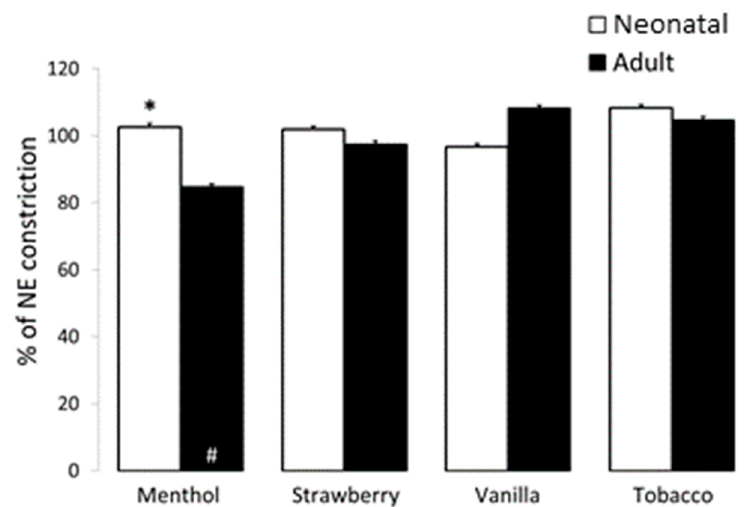
Figure 4. E ff ect of flavored solutions on vasodilation in newborn and adult pulmonary arteries (PA). The 1:1000 dilution of strawberry, vanilla, and tobacco flavored solutions did not impact vascular constriction in neonatal or adult PA. However, exposure to 1:1000 dilution of menthol flavoring resulted in significant relaxation of adult but not neonatal PA (# p < 0.05 as compared to time control, * p < 0.05 as compared to adult PA). Data are presented as mean + SEM. n = 3–8.